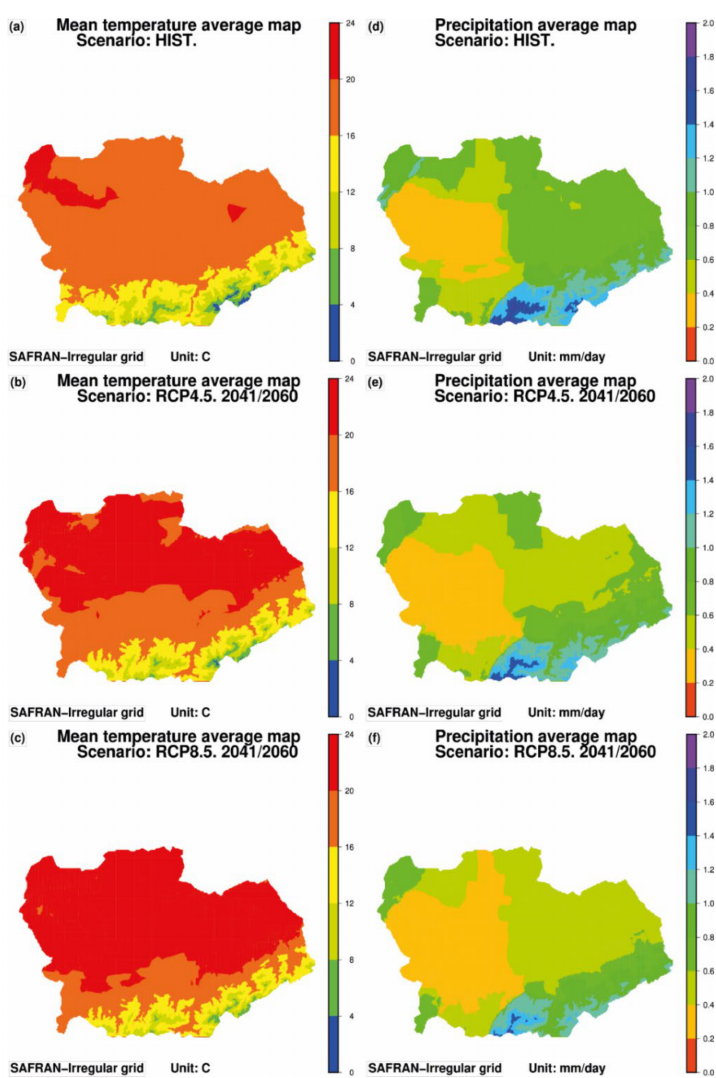
Figure 8. SAFRAN-irregular grid of Mean Air temperature (left) and precipitation (right) for the historical period ( a , d ) and for the projections according to the scenarios RCP4.5 ( b , e ) and RCP8.5 for 2041–2060 ( c , f ) over the Tensift